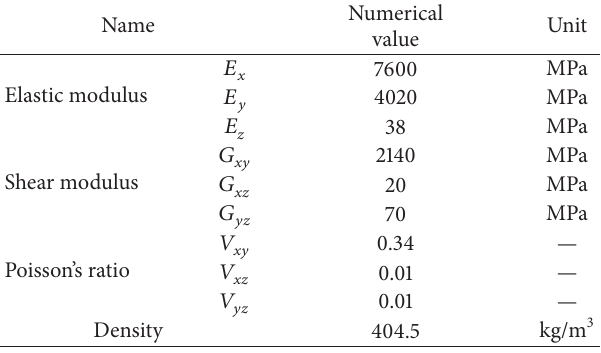
Table 1: Parameters of linear elastic material [18].